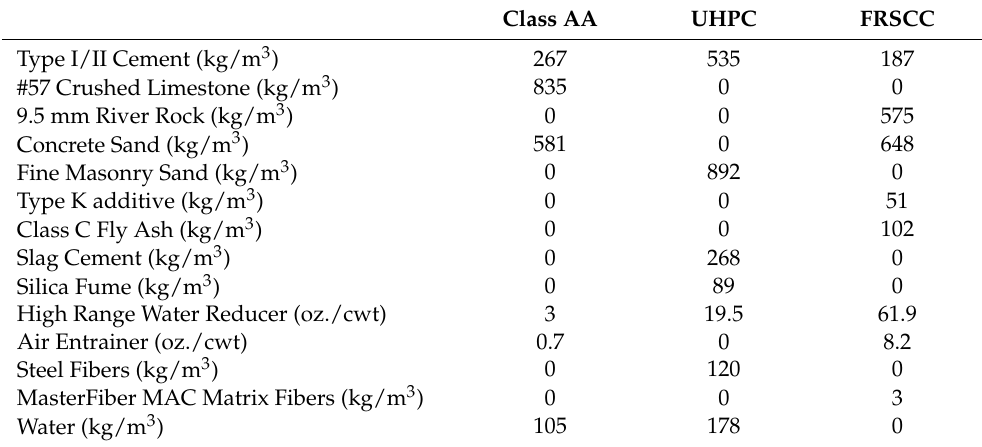
Table 1. Class AA, UHPC, and FRSCC mix